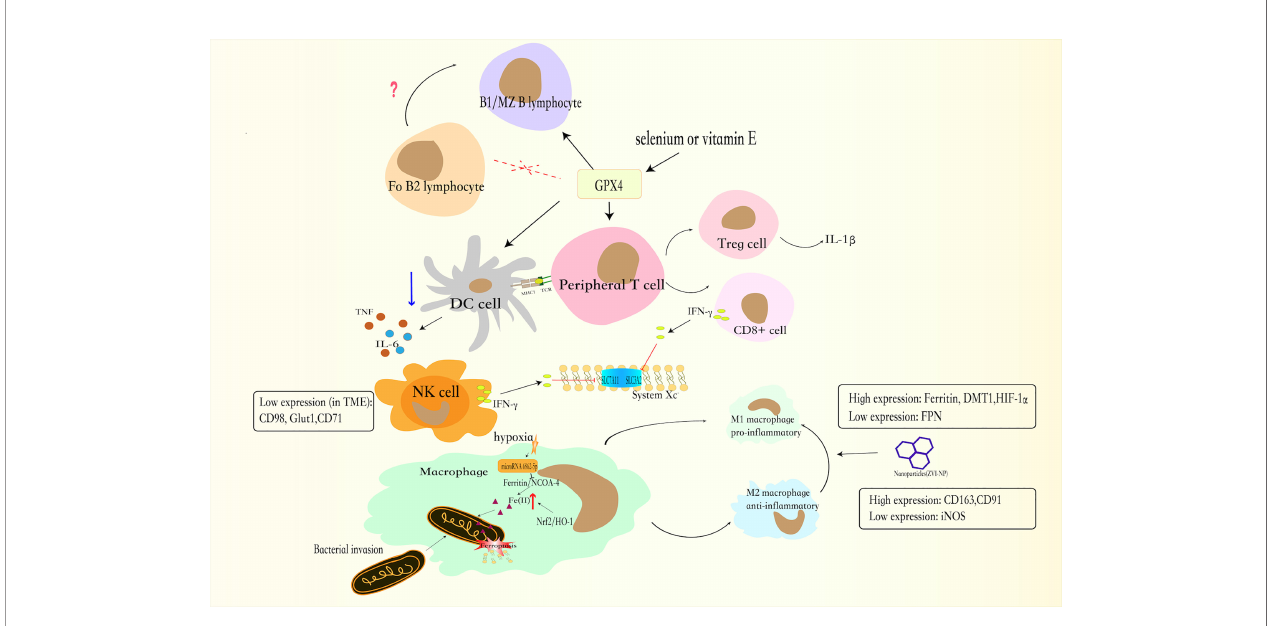
FIGURE 2 | The GSH-GPX4 axis has differential effects in the life cycle of immune cells. The GPX4 is critical to the functions of peripheral T lymphocytes. CD8+ T lymphocytes secrete less IFN g and Treg lymphocytes increases the production of IL-1 b , which facilitates T helper 17 (TH17) responses. Together with CD8+ T lymphocytes, NK cells can produce IFN g , which enhance the consumption of GSH, and increased the sensitivity of cell to ferroptosis. And NK cells, exposed to TME, have low expression of CD98, Glut1, and CD71 transferrin receptors. In the absence of GPX4, B1 and MZ B lymphocytes will cause ferroptosis. By contrast, Fo B2 lymphocytes do not require GPX4 for its maintenance. For DCs, GXP4 inhibitor blocks DCs maturation, weakens the ability of DCs to secrete TNF and IL6, and reduces MHC I